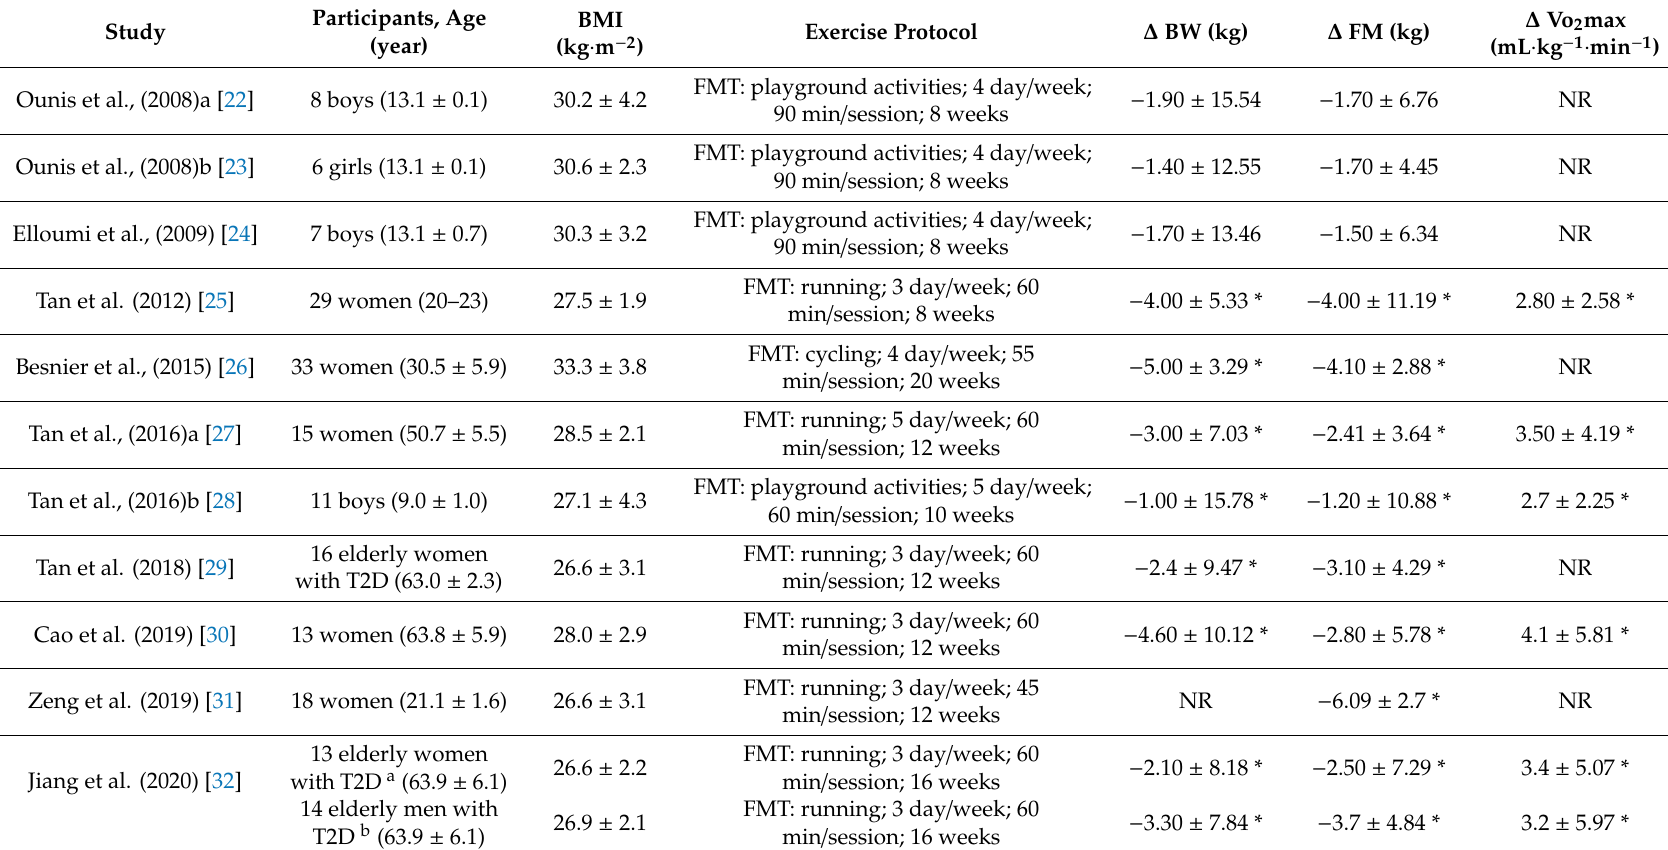
Table 1. Descriptive characteristics of the included